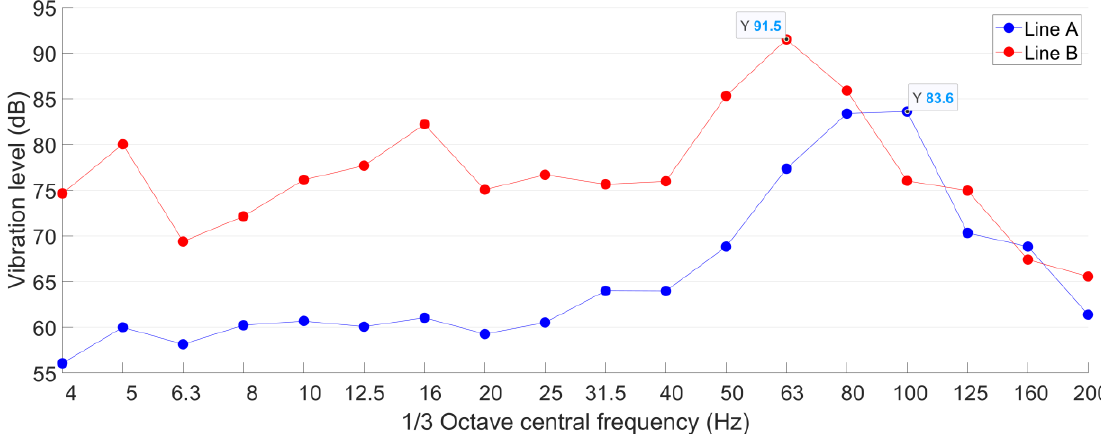
Figure 5. Tunnel wall 1/3 octave frequency division vibration acceleration level of Line A and Line